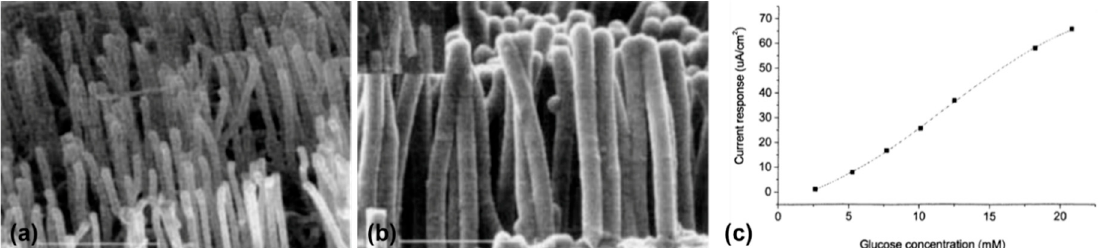
Figure 4. Scanning electron micrographs of an array of pure carbon nanotubes before the electrodeposition of polypyrrole ( a ) and the aligned coaxial nanowires after polypyrrole was deposited (the inset shows a single nanotube) ( b ). Anodic current response of the glucose sensor composed of polypyrrole, carbon nanotubes and glucose oxidase, depending on the concentration of glucose detected ( c ). Adapted with permission from [89]. Copyright 2003 John Wiley and Sons.